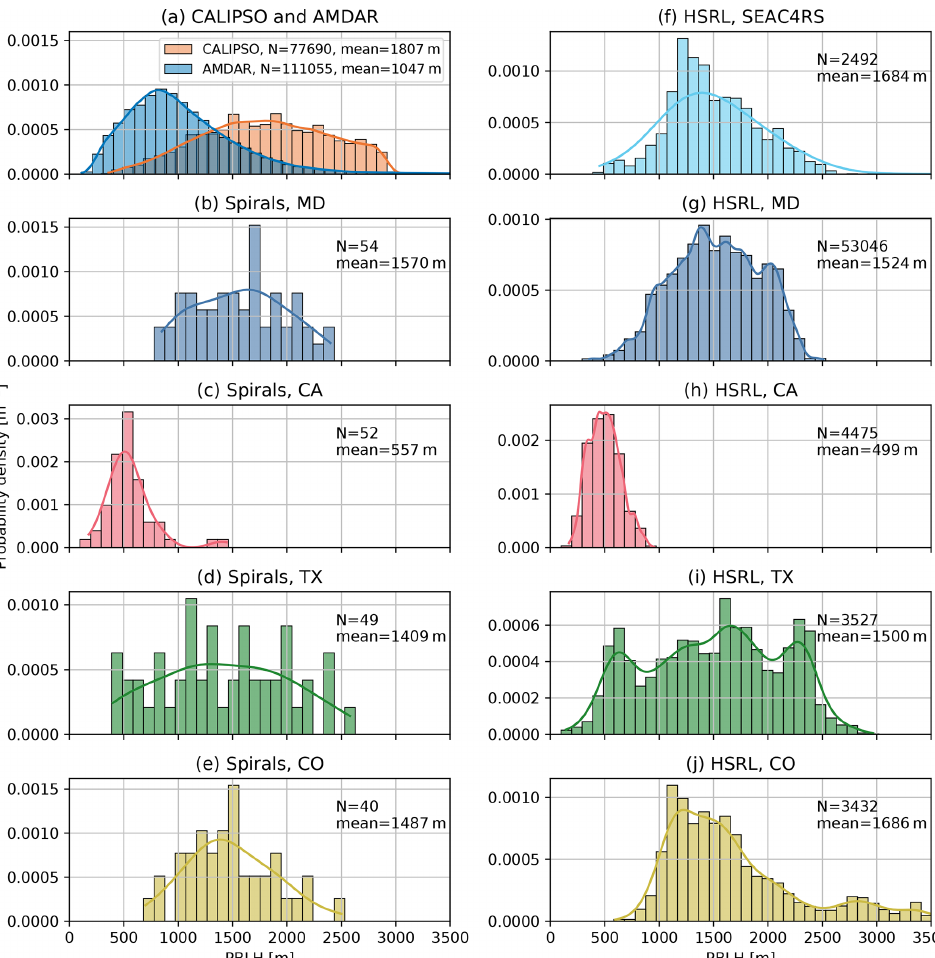
Figure 3. (a) Distributions of the AMDAR PBLH after quantile-regression-based filtering and the CALIPSO PBLH over the CONUS. (b– e) Distributions of the PBLH manually labeled using spiral profiles during the DISCOVER-AQ campaigns. (f–j) Distributions of the PBLH from HSRL during the SEAC4RS and DISCOVER-AQ campaigns. The airborne campaign data were limited to 12:30–14:30LST. The bins denote the normalized histograms, and the lines denote smoothed kernel density estimations. The total number of PBLH data points and the mean values are included in each